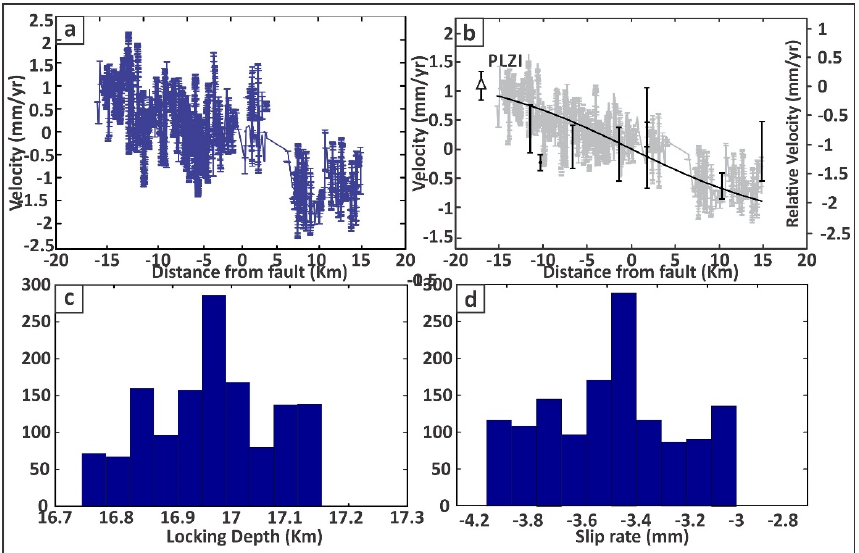
Figure 12. 2007–2009 fault-parallel velocity pro fi le derived from Envisat ascending data using ( a ) StaMPS and ( b ) ISBAS methods. Probability distributions for the ( c ) locking depth and ( d ) slip rate from bootstrap analysis of ISBAS results.